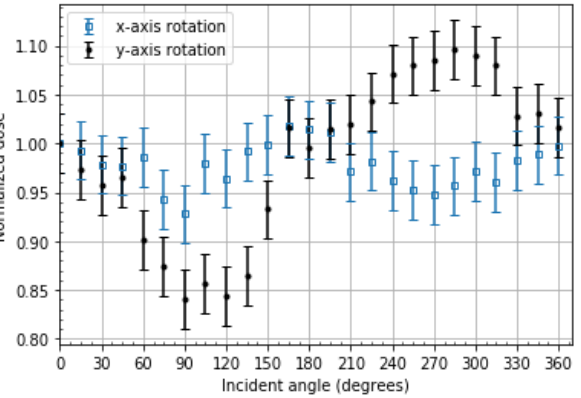
Figure 12. Angular dependence results. The radiation sensitivity of OSLDs as a function of the incident angle of 192 Ir gamma rays normalized to 0 ◦ . For both axes of rotation, the incident angle of 0 ◦ corresponds to the QR code face of the OSLD, 90 ◦ to the thin edge of the OSLD case, 180 ◦ to the OSLD lot number face, and 270 ◦ to the thick edge of the OSLD case. The error bars represent a standard deviation of four OSLD readouts.